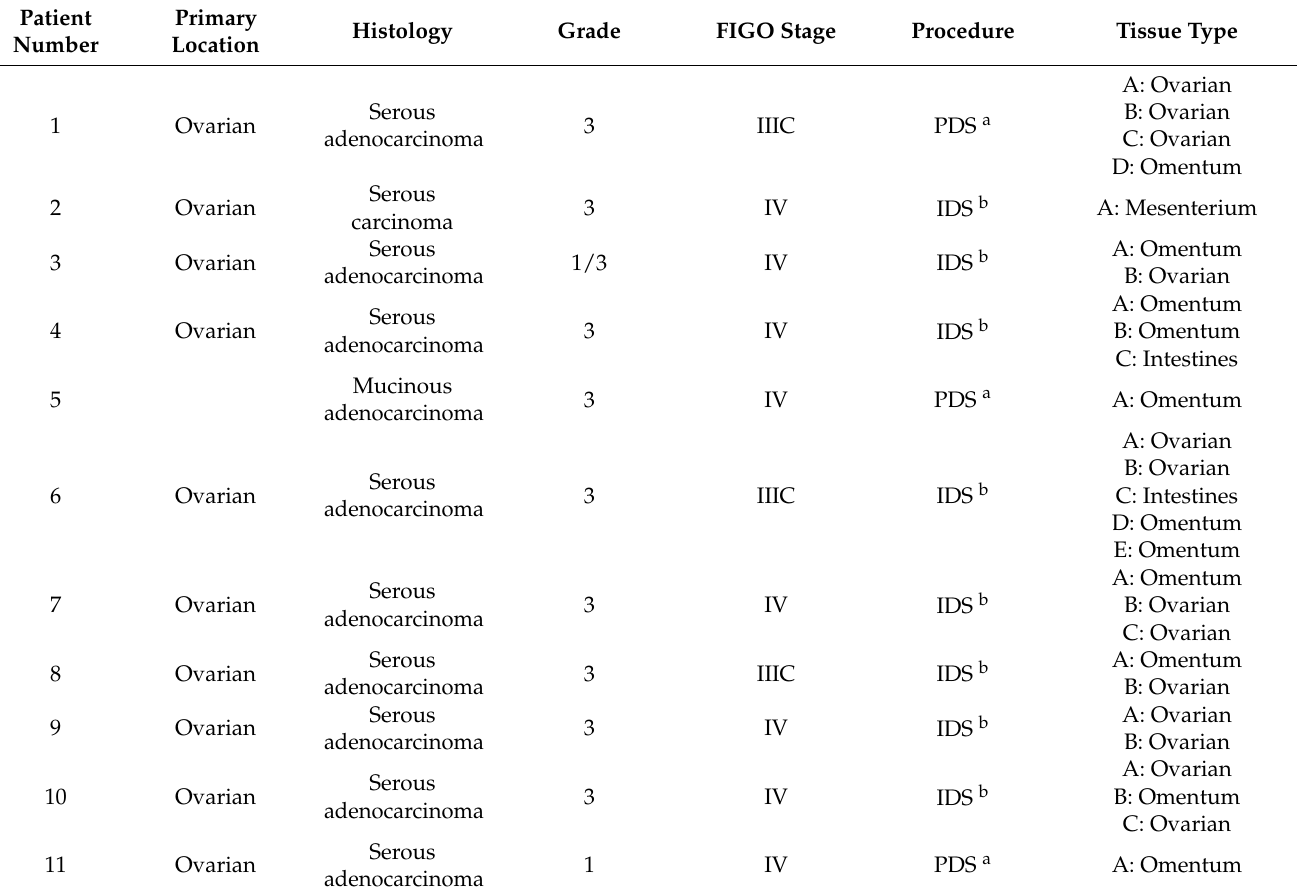
Table 1. Patient characteristics.